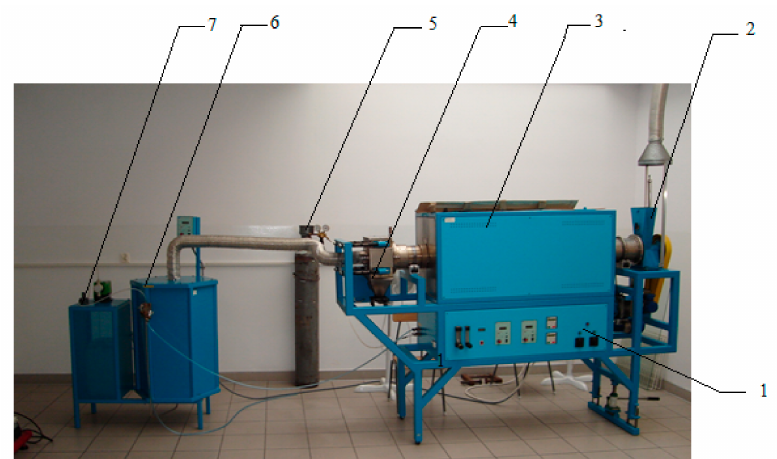
Figure 1. The testing stand of the high temperature modifications of activated carbon: 1. power and control cabinet, 2. activated carbon feeder, 3. insulating casing and rotary reactor, 4. activated carbon receiving chamber, 5. gas cylinder (air or CO 2 ), 6. superheater steam or gas heater, 7. water